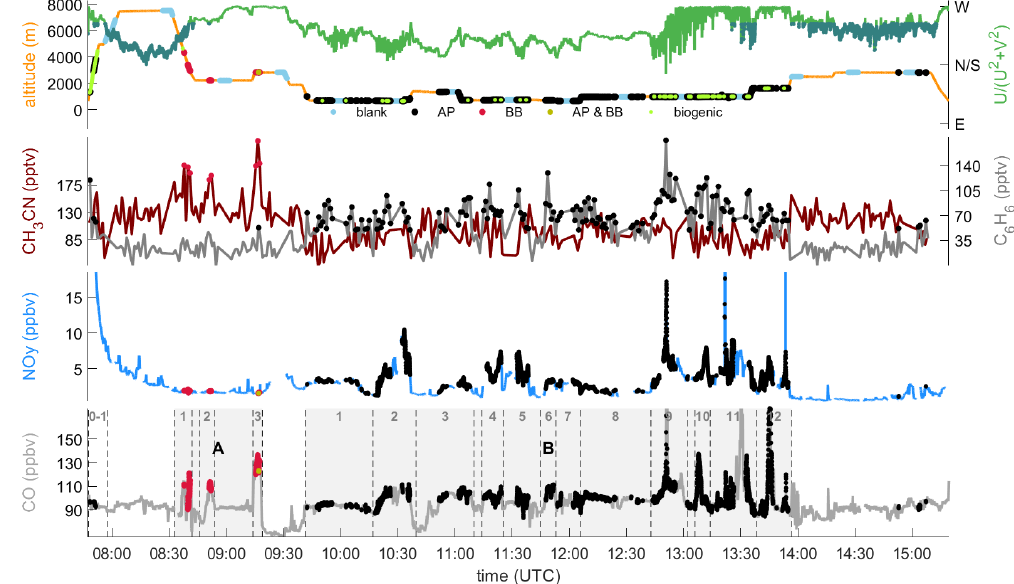
Figure 13. Time series for E-EU-08 on the 26 July 2017 used for the categorisation of plumes based on VOC measurements: altitude, wind direction, CH 3 CN, C 6 H 6 , and NO y as refinement. The wind direction (green line and axis) is given as U/ ( U 2 + V 2 ), − 1 is east wind ( E ), + 1 is west wind ( W ), values around zero have north or south components ( N / S ). South components are marked with dark green colour. Altitude (brown line, top panel) is colour coded in green during C 5 H 8 enhancements, in red during CH 3 CN enhancements, in black during C 6 H 6 enhancements, and in dark red during both CH 3 CN and C 6 H 6 enhancements. Additionally, blue colour-coded blank measurements of CH 3 CN, C 6 H 6 , and C 5 H 8 are given. In the bottom panel, final numbering of structures and plumes according to concentration enhance- ments are shown for CO. Colour-coding indicates CH 3 CN enhancements (red), C 6 H 6 enhancements (black), and both CH 3 CN and C 6 H 6 enhancements (brown).